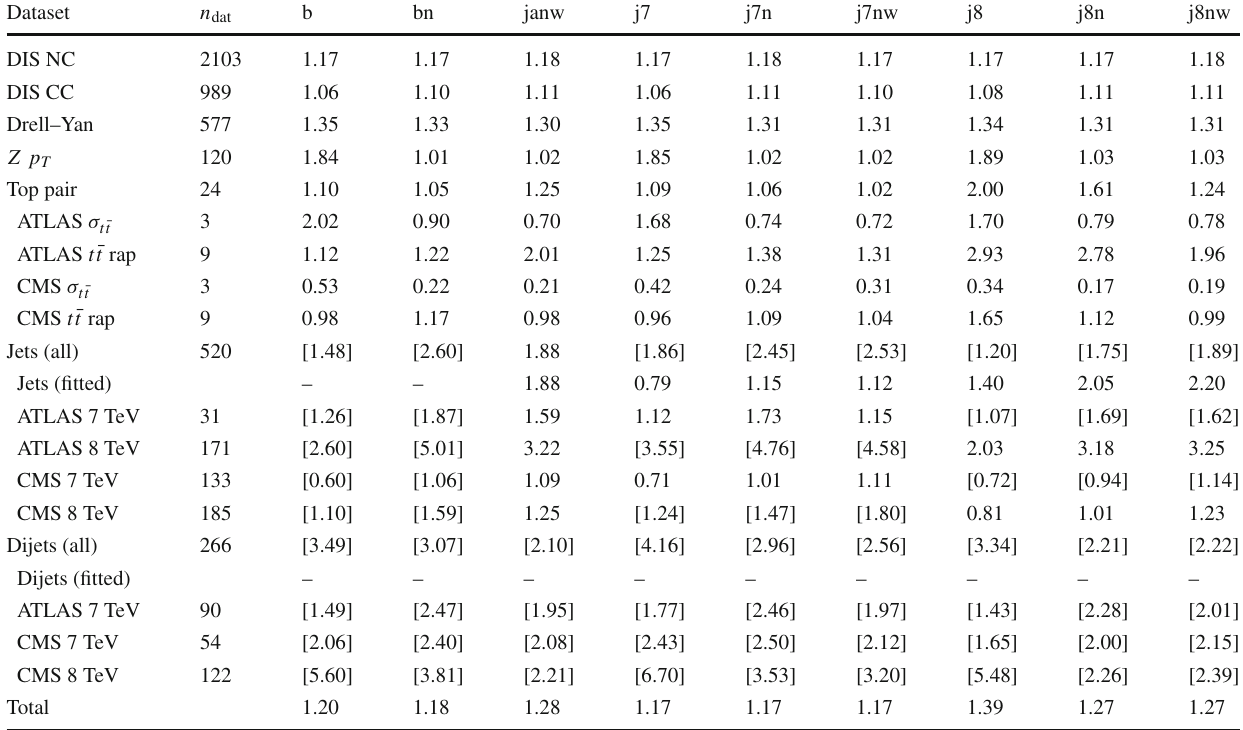
enclosed in square brackets. Combined results are also shown for all single-inclusive jet and for all dijet data, both for the full set, and for those included in each fit. The number of datapoints in each dataset is also